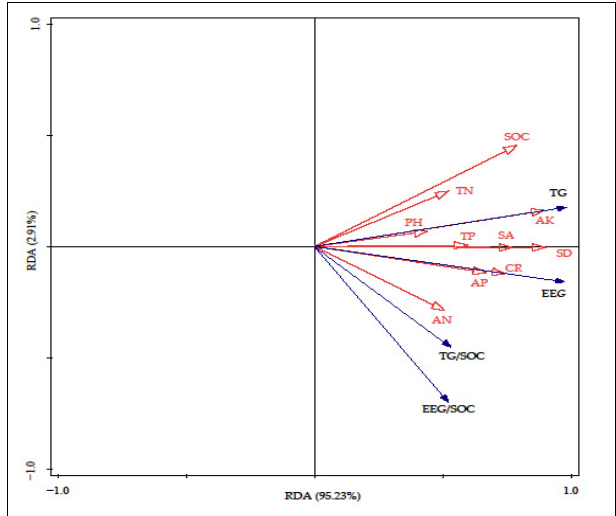
Figure 4. Redundancy analysis of GRSP and environmental factors. Hollow arrows point to explana- tory variables; solid arrows point to response